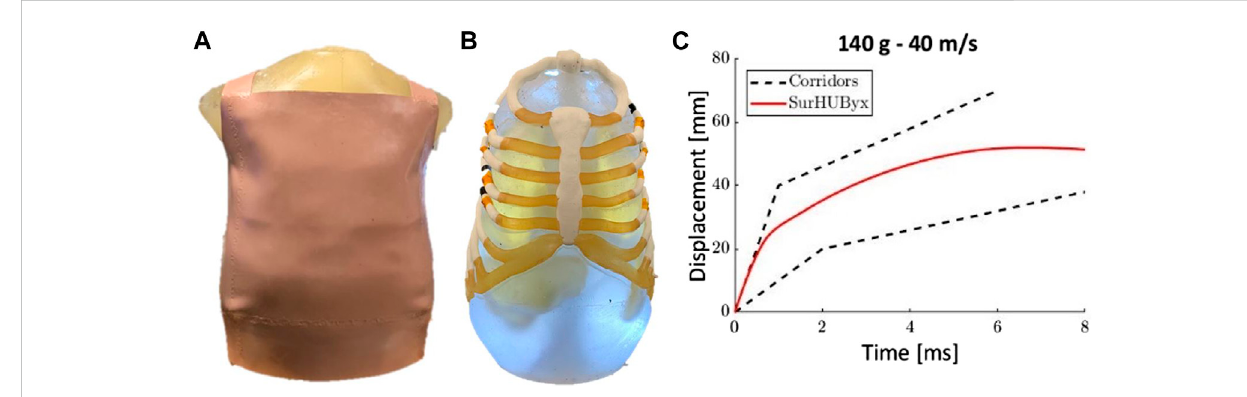
FIGURE 8 SurHUByx external view (A) , SurHUByx mediastinal and thoracic view (B) and SurHubyx displacement time curve for case B of the Bir experiments (C)